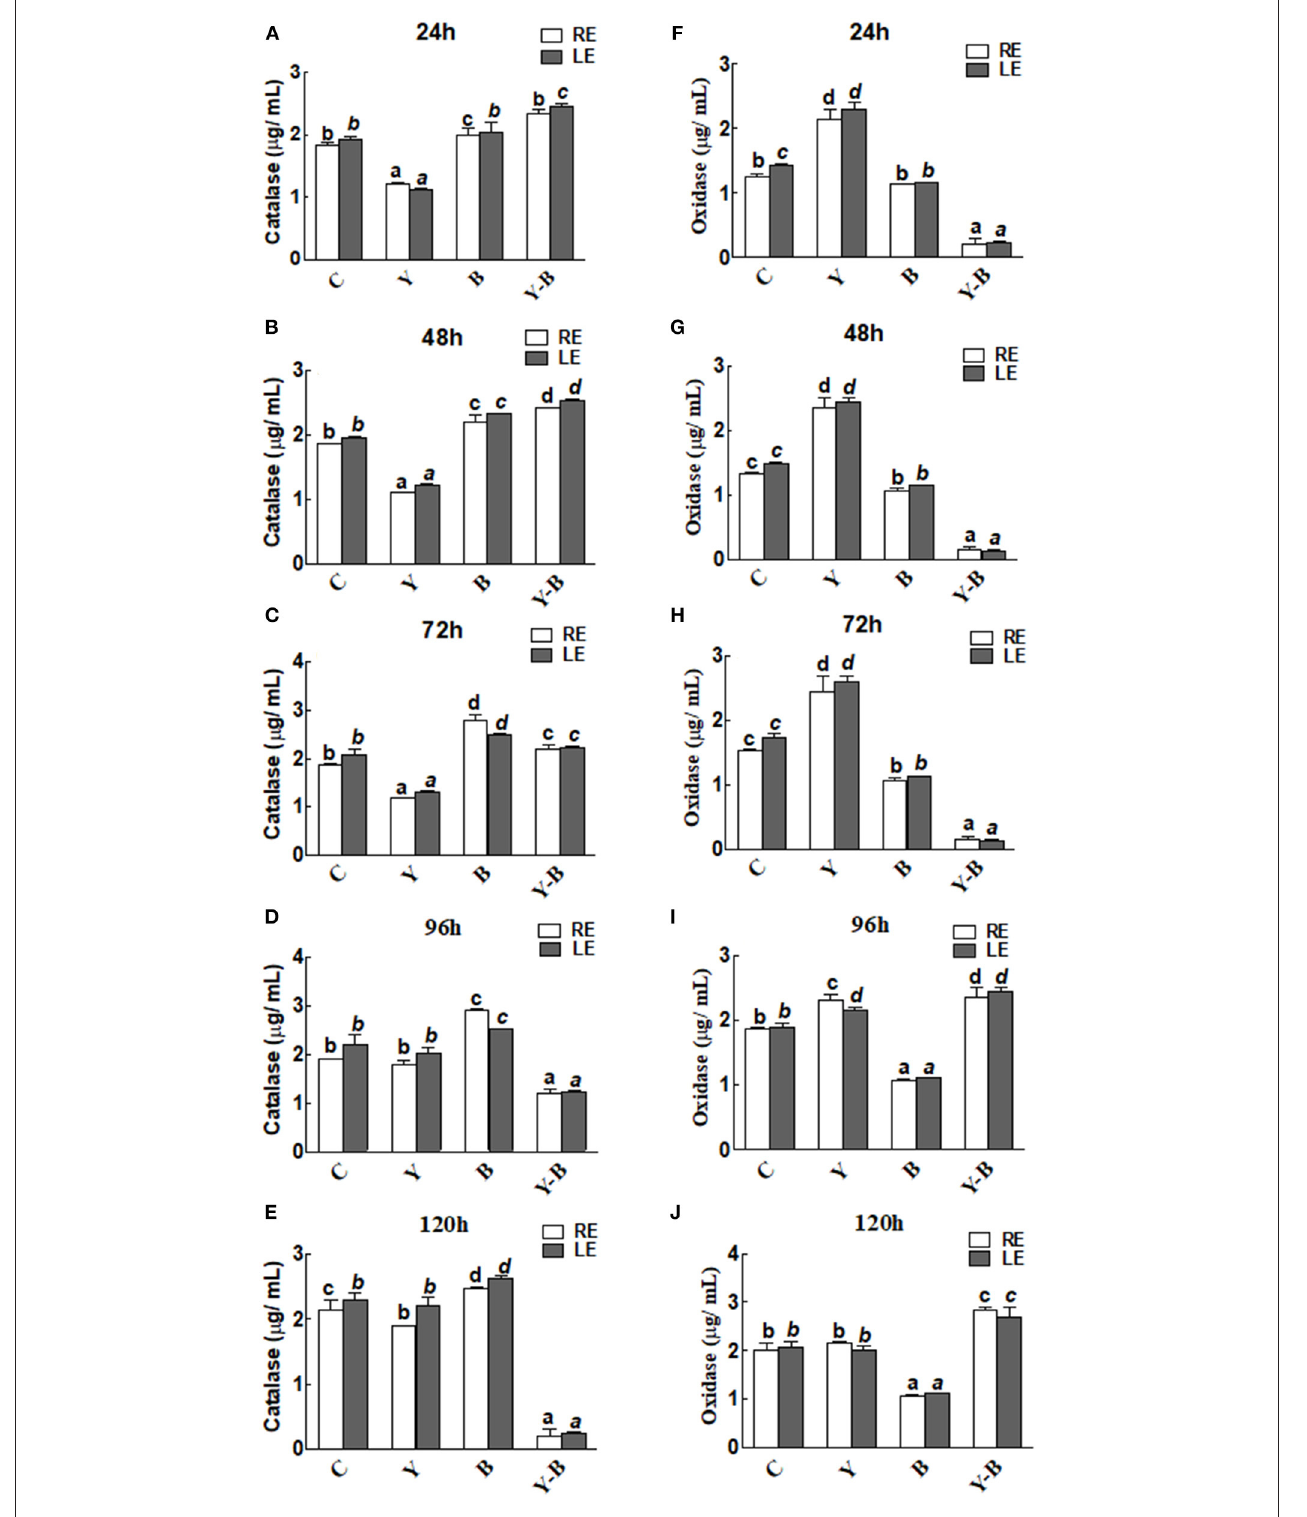
FIGURE 4 | Determination of catalase (A–E) and oxidase (F–J) activity in the leaf extracts (LE) and root exudates (RE) of 11-days-old maize seedlings exposed to different treatments, including C (control); Y (yucasin), B ( Bipolaris spp.), Y-B (yucasin- Bipolaris spp.) for the different time duration. Data are mean from three independent experiments with standard error bars. Bars labeled with different letters are significantly different (Duncan test; p < 0.05).